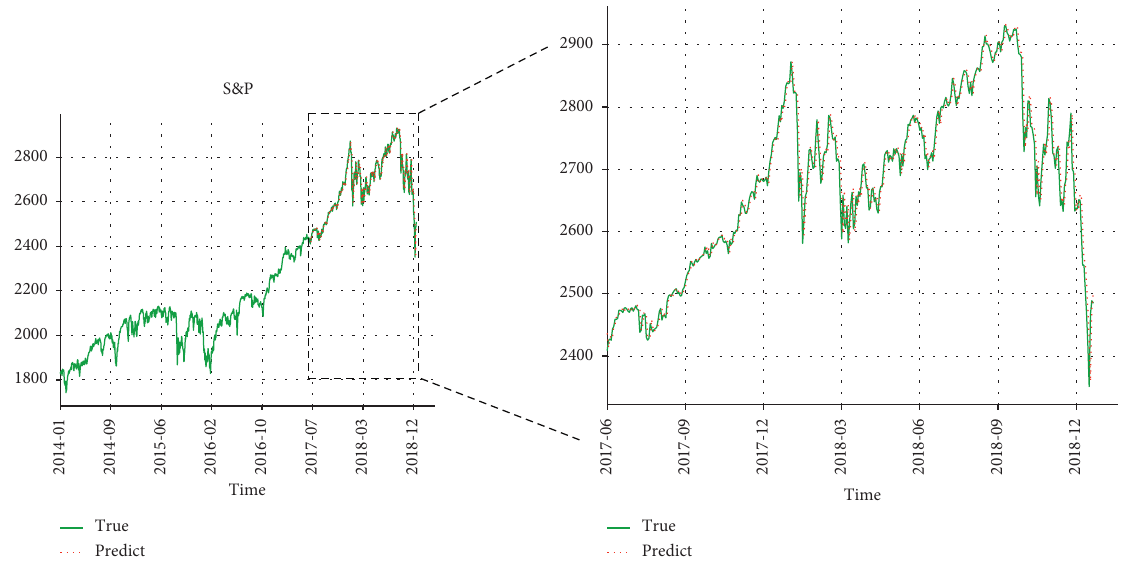
Figure 5: The S&P index prediction with consideration of the bitcoin price. Table 2: RMSEs of the